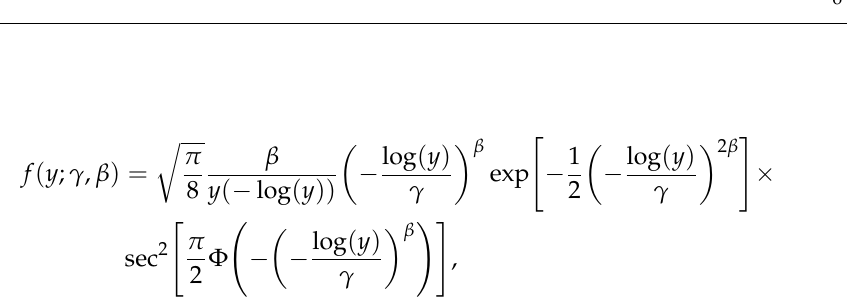
respectively. The PDF plots of the TUGHN distribution in Figure 3 show left-skewed, right-skewed, reversed-J, J, and bathtub shapes. Although the TUGHN distribution does not show the approximate symmetric shape displayed by the SUGHN, it has an increasing or J shape that is not exhibited by the SUGHN and CUGHN distributions. Hence, the TUGHN distribution is a candidate for modeling bounded data with such characteristics.